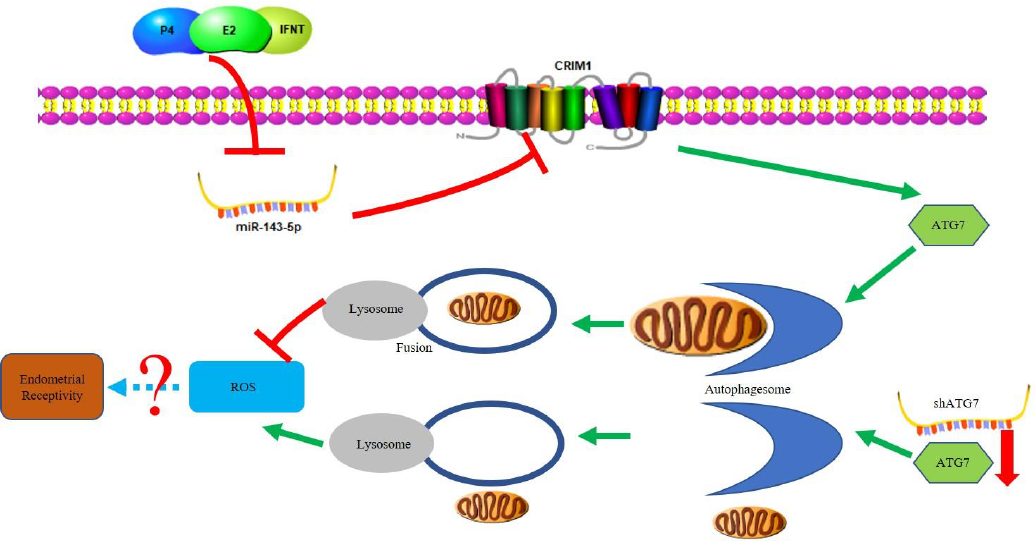
Figure 7. Proposed network of miR-143-5p–CRIM1 autophagy in regulating endometrial receptivity. Our results suggest that hormones and IFN-τ promote CRIM1 expression by inhibiting the level of miR-143-5p, while CRIM1 regulates endometrial receptivity phenotypes through autophagy activation to reduce the production of ROS.